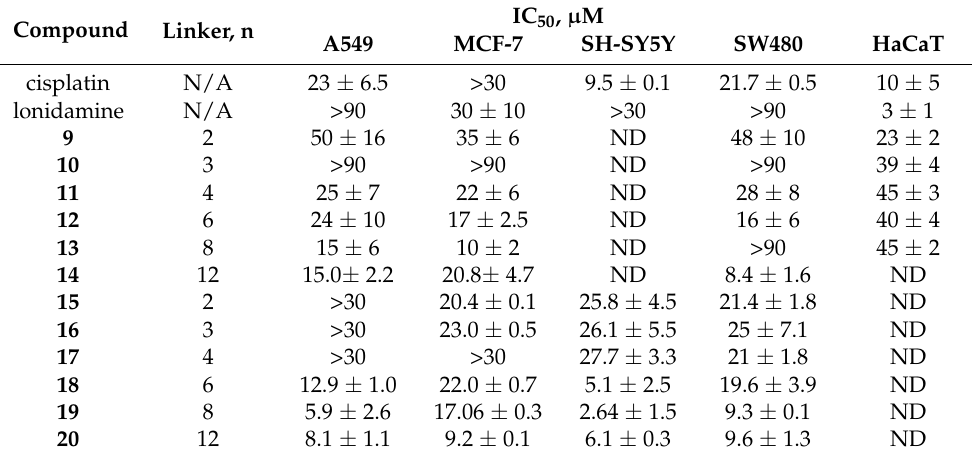
Table 4. Antiproliferative activity against human tumour